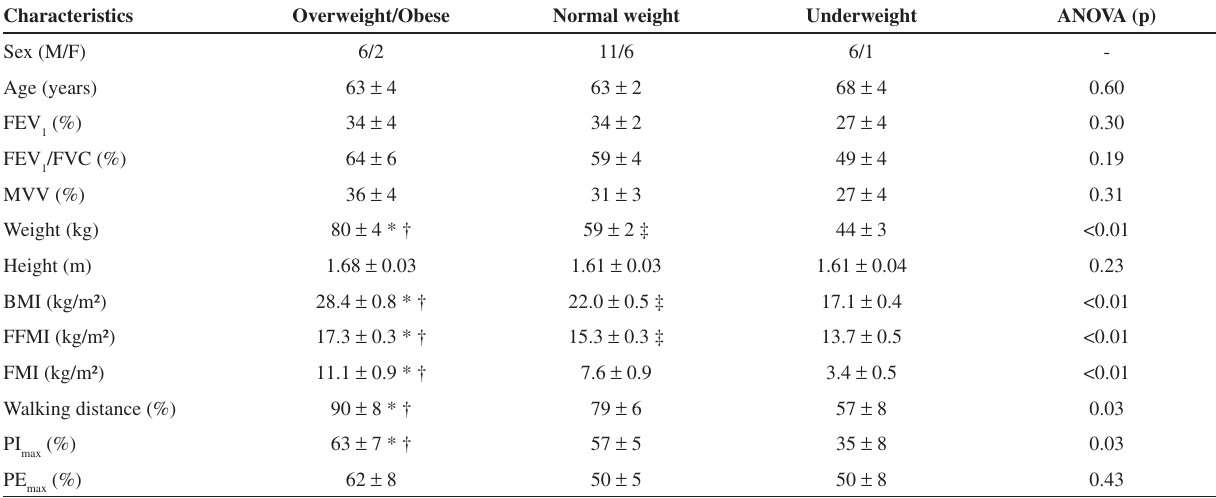
Table 1 - Characteristics of the patients according to their nutritional status. Characteristics